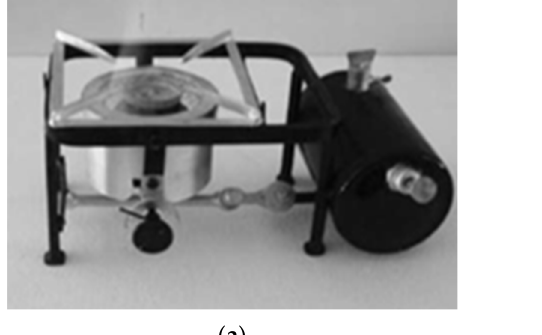
Figure 10. ( a ) Different designs of kerosene wick stoves—( i ) kerosene wick (woven fiberglass) stove